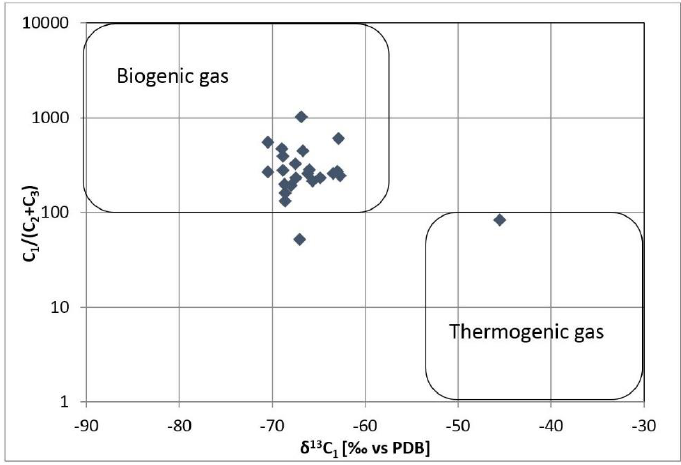
Figure 3. Genetic classification of gases sampled in Miocene formations of Carpathian Foredeep on a Bernard diagram (after [48], modified).